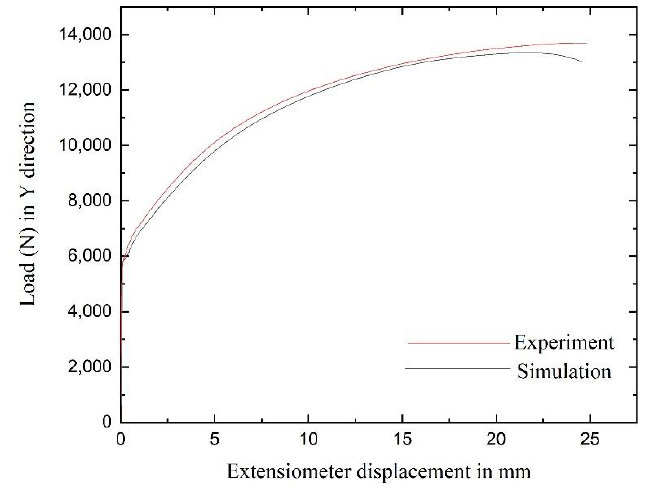
Figure 7. Load – Extensiometer-displacement curves for the simulation and for the experiment. Figure 7. Load–Extensiometer-displacement curves for the simulation and for the